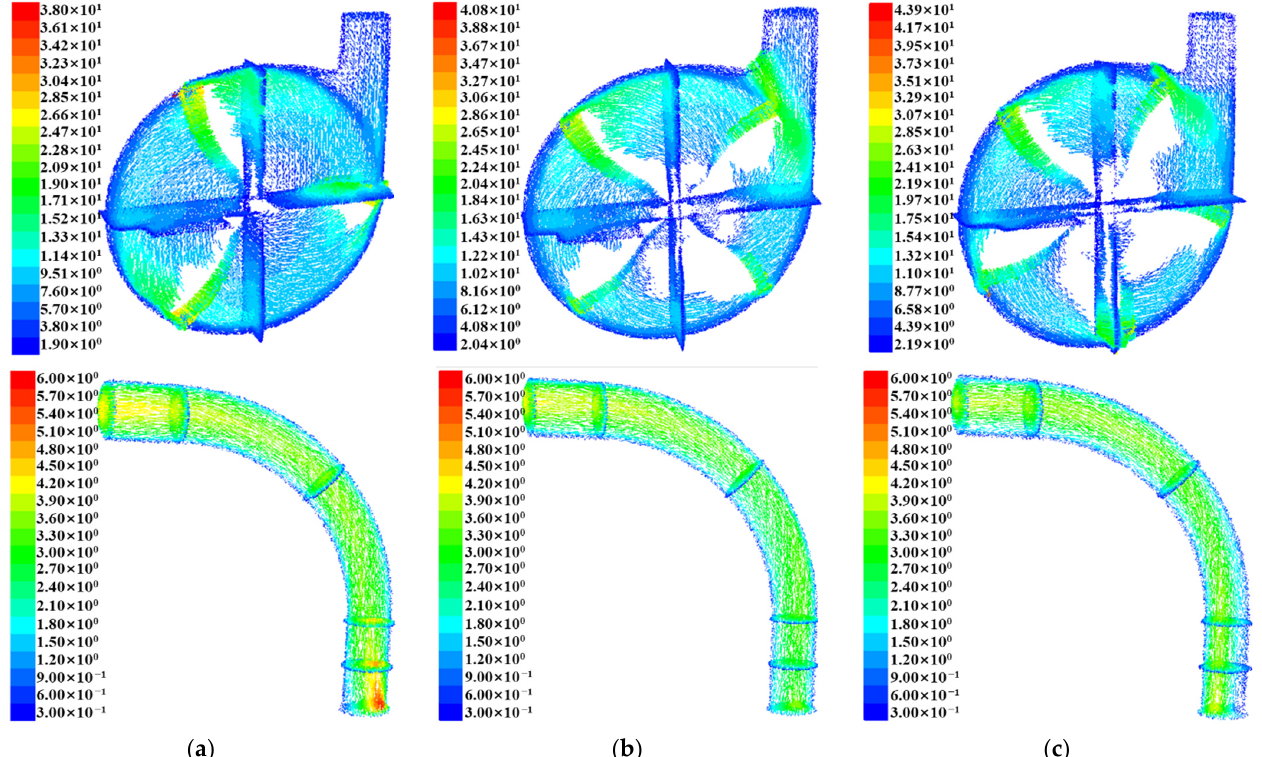
Figure 8. The velocity vector diagram of the material phase in the device with different number of blades. ( a ) The number of blades was three. ( b ) The number of blades was four. ( c ) The number of blades was